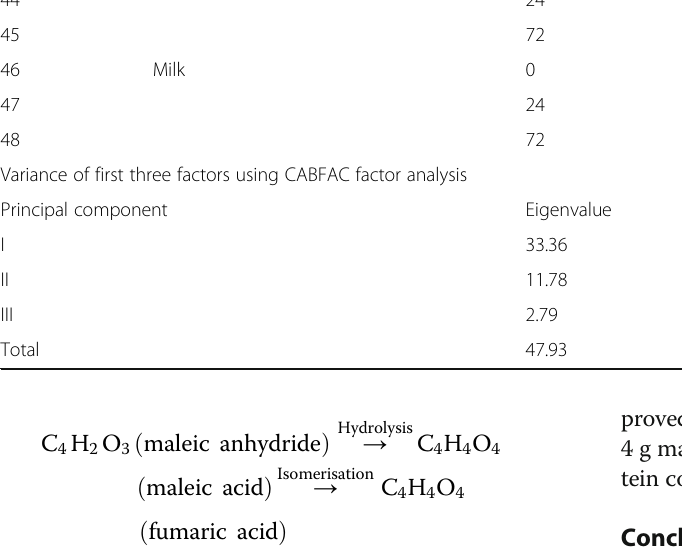
Variance of first three factors using CABFAC factor analysis